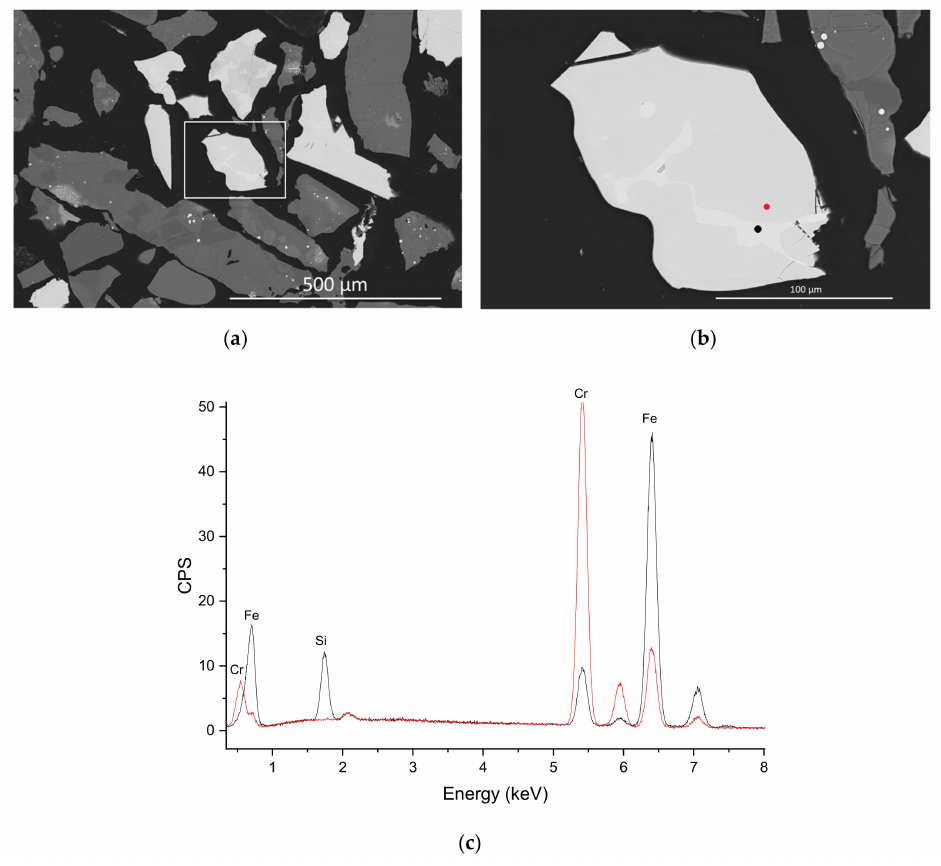
Figure 4. SEM-BSE image of HC FeCr slags. ( a ) Dark grey silicate slag particles and light-colored FeCr metal particles grains. ( b ) Detail of FeCr metal grain, with indication of EDX measurement locations (colored circles). Darker areas in the metal particle contain more chromium, as shown by EDX measurements in ( c ).